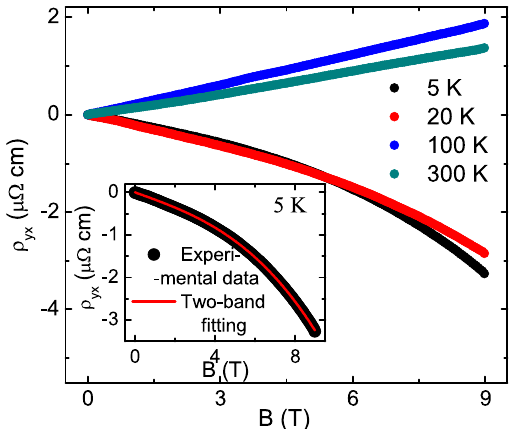
Figure 3. Hall resistivity for LaBi single crystal. Magnetic field dependence of Hall resistivity at different temperatures. Inset shows the classical two-band fitting of ρ yx